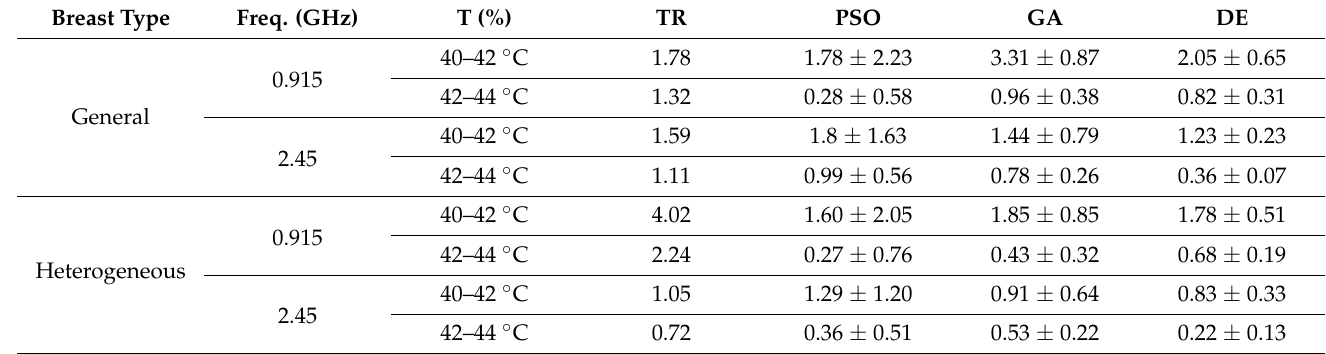
Table 4. Mean and standard deviation of damaged healthy tissue rate for two breast models using HTP optimization